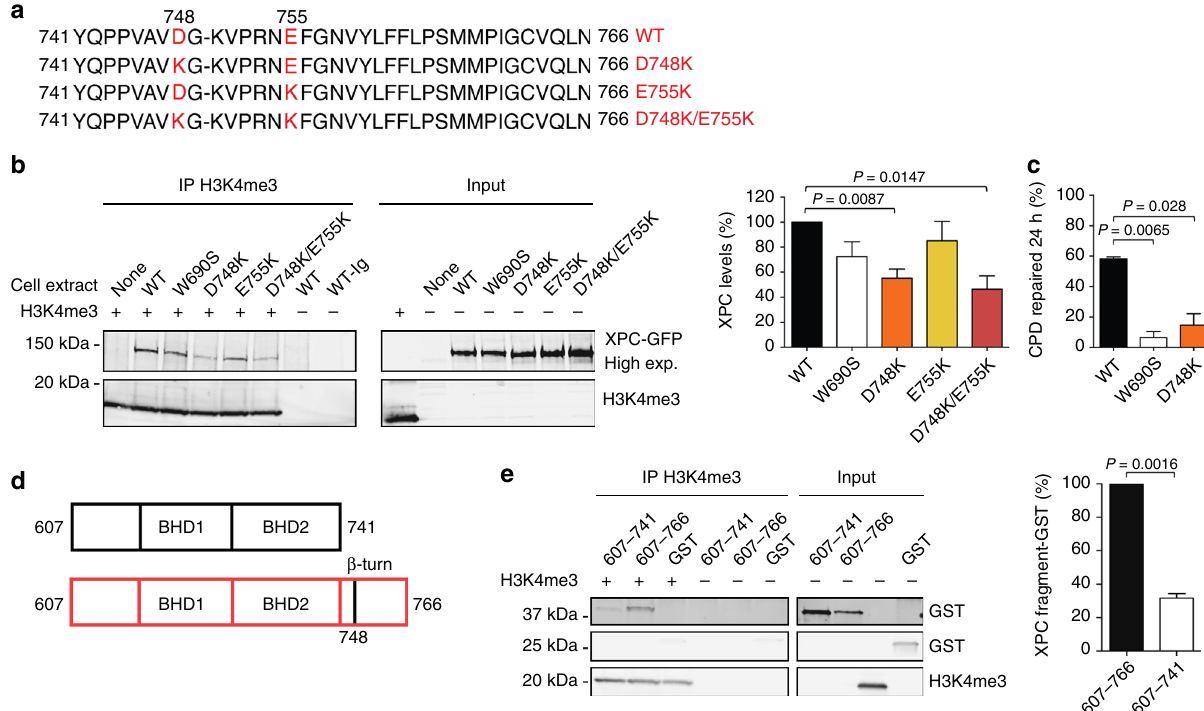
Fig. 8 Histone-interacting domain in human XPC protein. a Sequence of the β -turn in human XPC protein showing the introduced charge inversions. b Association of wild-type (WT) or mutant XPC with H3K4me3. The indicated GFP fusions were expressed in XP-C fi broblasts and 0.3-M NaCl extracts were incubated with recombinant H3K4me3 (2 µ g), followed by immunoprecipitation using anti-H3K4me3 antibodies. Quanti fi cations of co-immunoprecipitated XPC, shown as the percentage of wild-type controls, were carried out relative to the respective input. Error bars indicate s.e.m ( n = 3, one-sample t-test). c Excision of CPDs in XP-C fi broblasts transfected 24 h before UV radiation (10 J m – 2 ) with vectors coding for wild-type (WT) XPC or the indicated mutants ( n = 3, each experiment with 4 replicates, two-tailed t-test). Immunoassays for CPD quanti fi cations were carried out after a 24-h repair incubation. d Domains in polypeptide fragments XPC 607 – 741 and XPC 607 – 766 . e The indicated XPC polypeptides fused to glutathione- S - transferase (GST; 4 µ g) and GST alone (2.5 µ g) were incubated with H3K4me3 (2 µ g), immunoprecipitated with anti-H3K4me3 antibodies and visualized using anti-GST antibodies. Quanti fi cation of co-isolated polypeptides relative to the respective input ( n = 3, one-sample t-test). Values obtained with the larger fragments are set to Quantitative RT-PCR was performed using the KAPA SyBR FAST Universal qPCR Kit (KAPA BIOSYSTEMS) according to the manufacturer ’ s protocol. Reactions were carried out in duplicates using the CFX384 Real-time System C1000 Touch Thermal Cycler. Relative gene expression levels were presented as 2 − ΔΔ CT , nor- malized against GAPDH and Beta-2 microglobulin (B2M), and presented relative to controls treated with non-coding siRNA. The Quantitative RT-PCR primers were obtained from Microsynth (Supplementary Table 2).